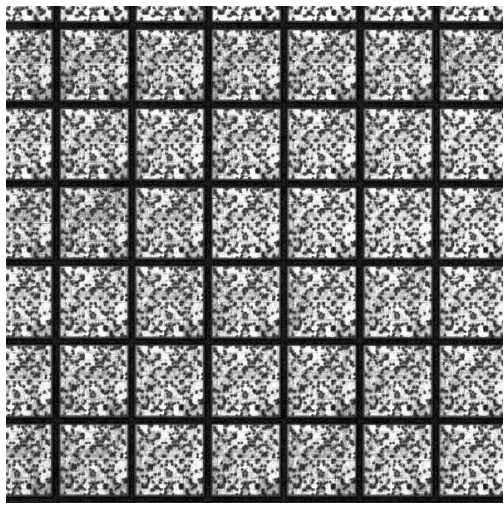
Figure 3. Initial template.